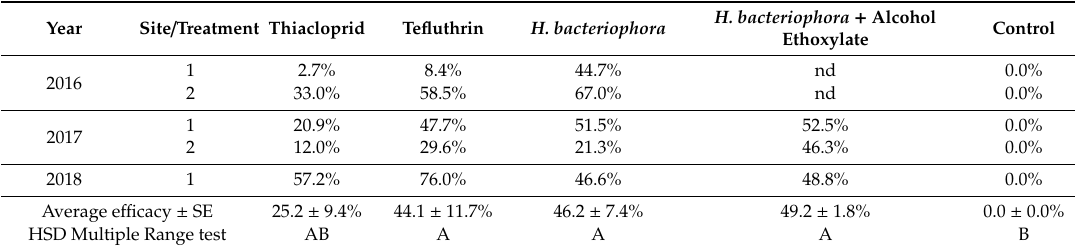
Table 3. Overall treatment e ffi cacy calculated from the three-year dataset accumulated on two experimental sites. E ffi cacy is expressed as the average reduction of beetles that emerged in di ff erent treatments compared to the control emergence (%). n = 25 for all treatments, except 15 for H. bacteriophora + alcohol ethoxylate. Columns not sharing the same letters are significantly di ff erent. SE —standard error; nd —no data.